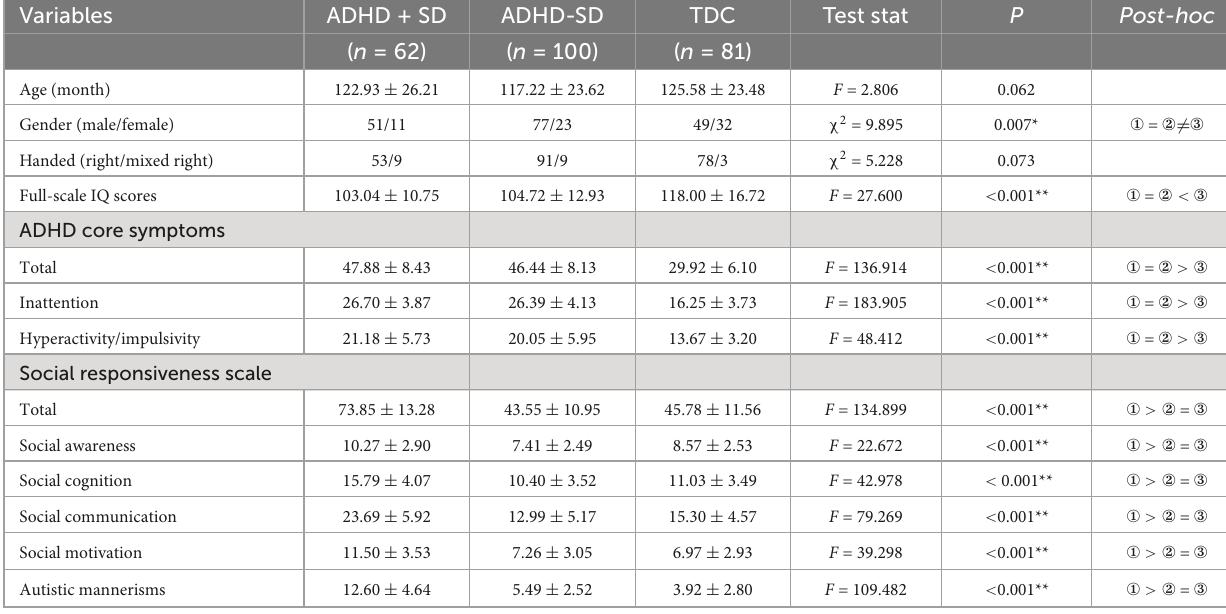
TABLE 1 Demographic and clinical information. Variables ADHD + SD ADHD-SD TDC Test stat P